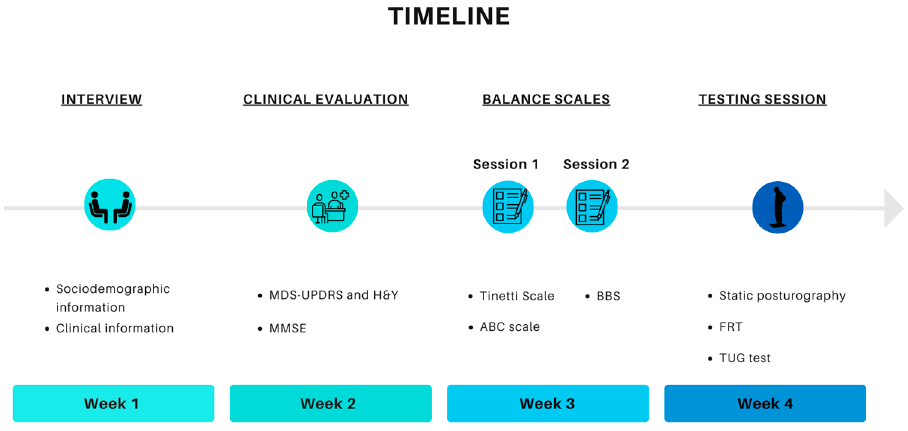
Figure 2. Data collection timeline.